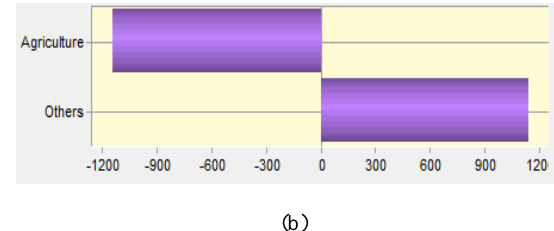
Figure 9. (a) Gain and lose graph, (b) Net change graph